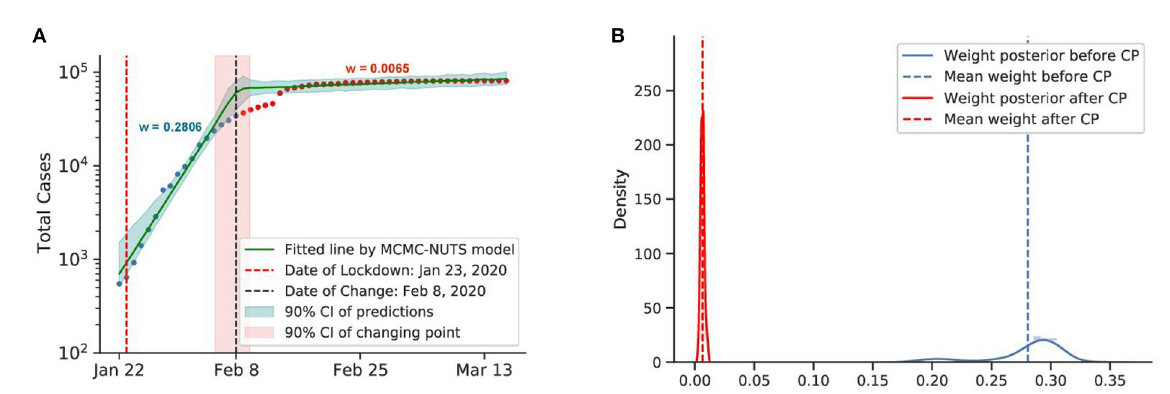
FIGURE5 Posterior for China. As the initial epicenter of the outbreak, cases in China skyrocketed in January 2020. China started applying a swift and stringent lockdown from January 23, 2020 (70), starting with the city of Wuhan, and managed to largely bring the outbreak under control in February, 2020. The growth rate was suppressed staggeringly from 0.2806 to a mere 0.0065, with the change-point estimated around February 8, 2020. (A) Fitted graph for China with change-point on February 8, 2020. (B) Posterior distribution of weights (transmission rate) before and after